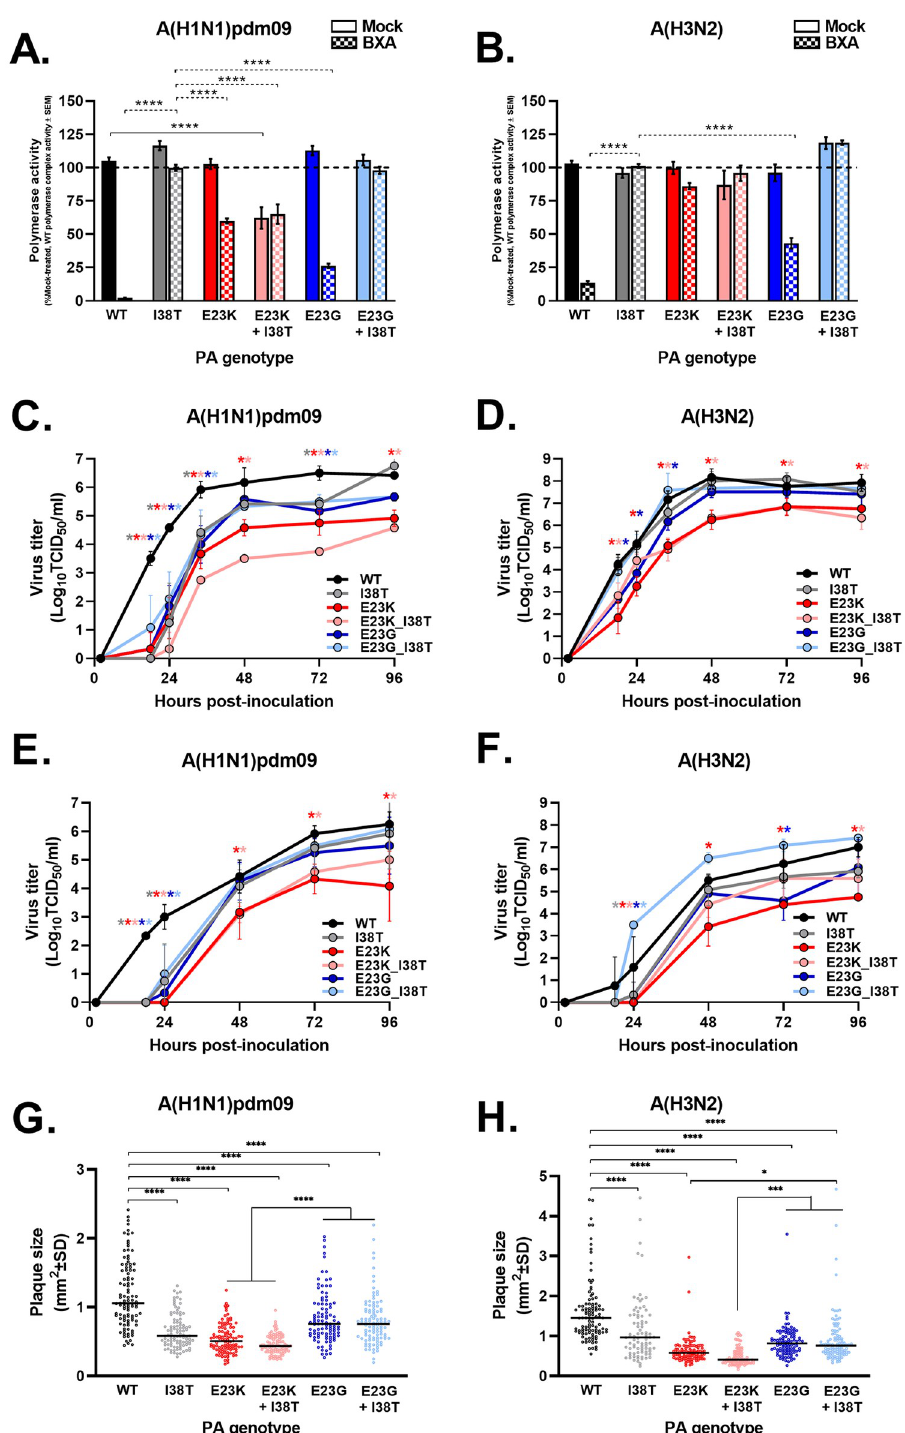
Fig 1. In vitro fitness of PA E23G/K influenza A viruses. Fitness profiles were defined in three assays. A, B) In the minireplicon assay, HEK293T cells were transfected with plasmids expressing virus polymerase complex proteins, the indicated PA mutant, a luciferase reporter of viral polymerase activity, and a β -galactosidase transfection control reporter plasmid. Cells were mock treated (with DMSO, solid bars) or treated with BXA (5 nM, checkered bars) 1 h before and 24 h after transfection. The polymerase activity luciferase output was normalized to the β -galactosidase signal for each data point then compared to the activity of mock-treated WT polymerase (100% activity) or I38T polymerase (100% BXA “resistance”). The data are representative of combined replicates (2–3 per experimental group)